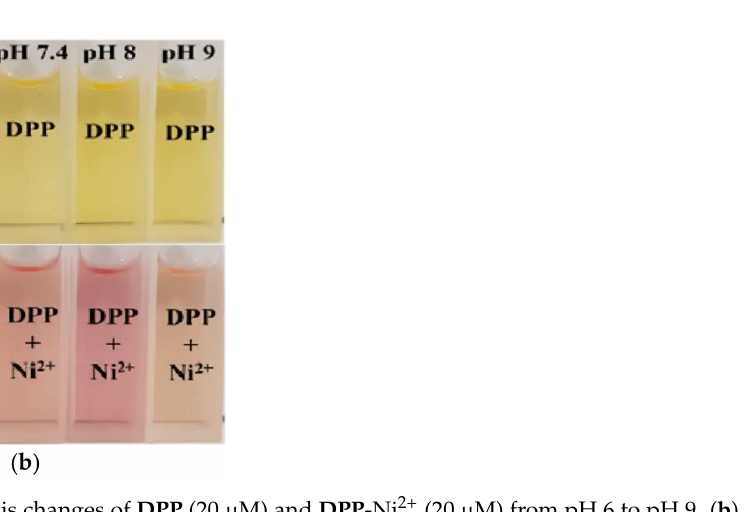
Figure 8. ( a ) UV-vis changes of DPP (20 µ M) and DPP -Ni 2+ (20 µ M) from pH 6 to pH 9. ( b ) Color changes of DPP (20 µ M) with Ni 2+ (16 eq.) in pH 6 to 9. DPP showed the ability to sense Ni 2+ at pH 7–9. Test-strip experiments were per- formed with filter papers coated with DPP for practical application. DPP showed a colori- metric change from yellow to purple at 50 µ M Ni 2+ (Figure 9a) and selectively detected Ni 2+ among varied metal ions (Figure 9b). This result indicated that DPP could be applied to detecting Ni 2+ by using a test strip.